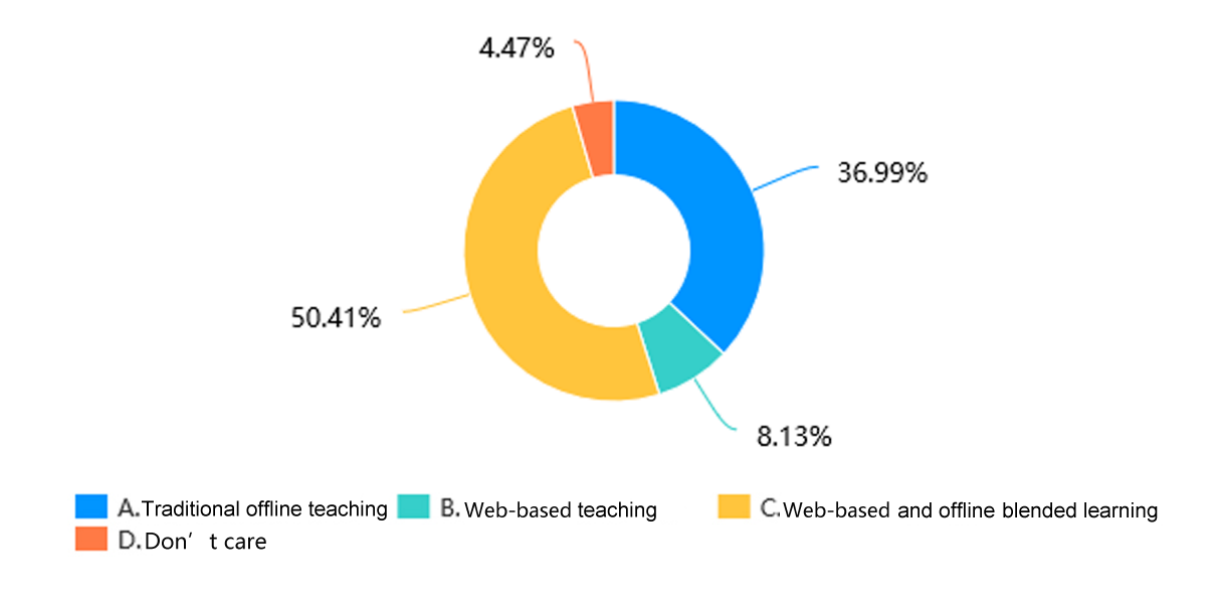
Figure 8. The proportions of students who chose different teaching methods of pathology after the COVID-19